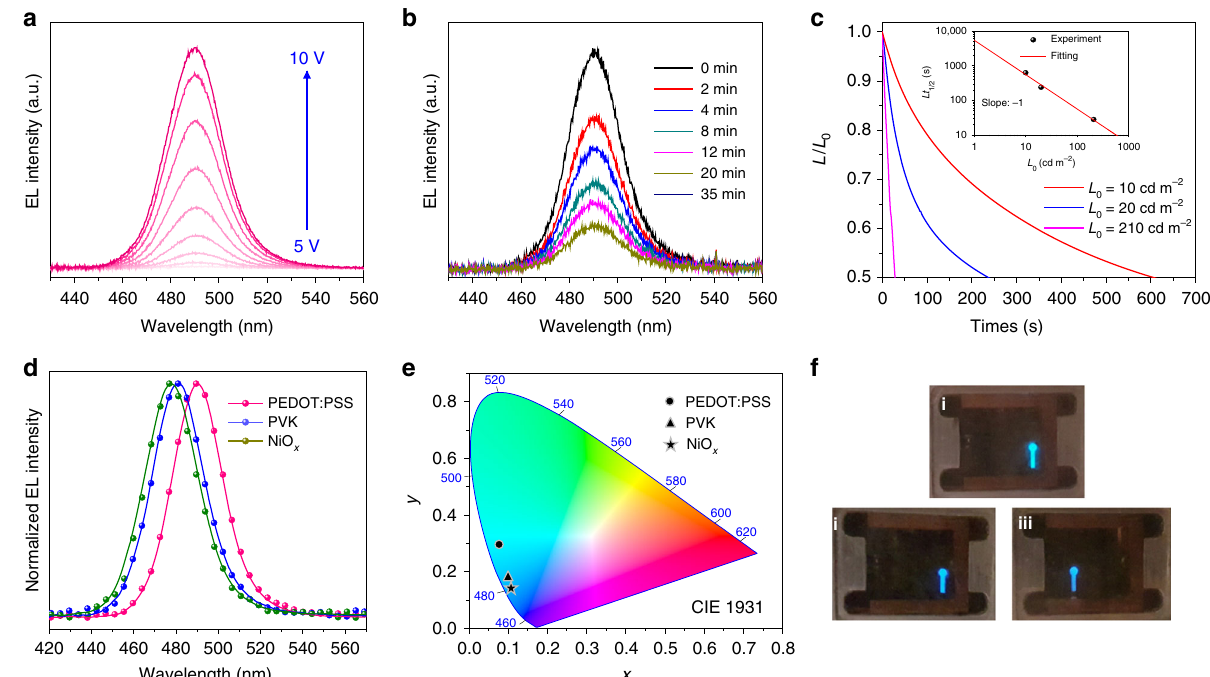
Fig. 5 EL spectra of PeLEDs. a EL spectra of PeLEDs operating under different voltage. b EL spectra of PeLED operating with various exposure times. c Lifetime measurement of the PeLEDs device at different initial luminance. The inset is estimated half-lifetime using the stretched exponential decay. d EL spectra and e CIE 1931 chromatic coordinates of the PeLEDs with PEDOT:PSS, PVK or NiO x as HTL. f Digital photographs of the operating PeLEDs with PEDOT:PSS (i), PVK (ii), and NiO x (iii) as the HTL materials,